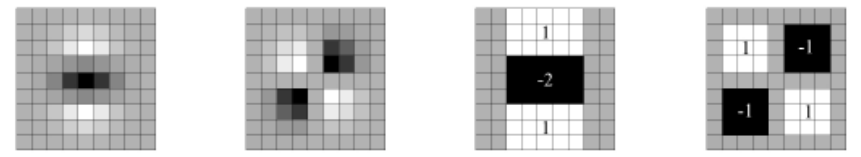
Figure 3. Laplacian of Gaussian approximation. From left to right: the Gaussian second–order partial derivative in the y- and xy-direction (L yy and L xy ); weighted box filter approximations for the second–order Gaussian partial derivative in the y- and xy-direction (D yy and D xy